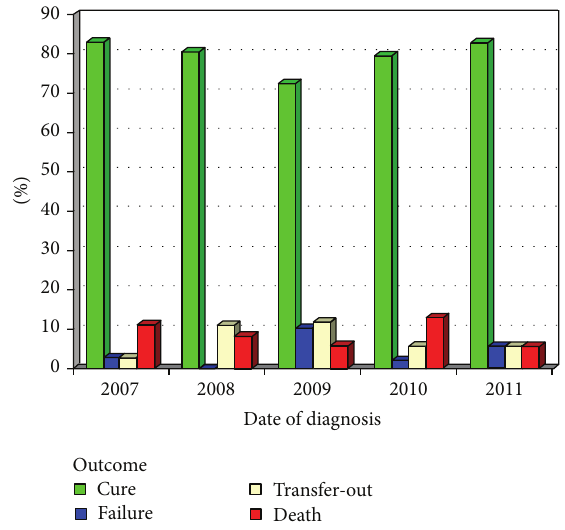
Figure 2: Outcome of pulmonary tuberculosis patients regarding years of